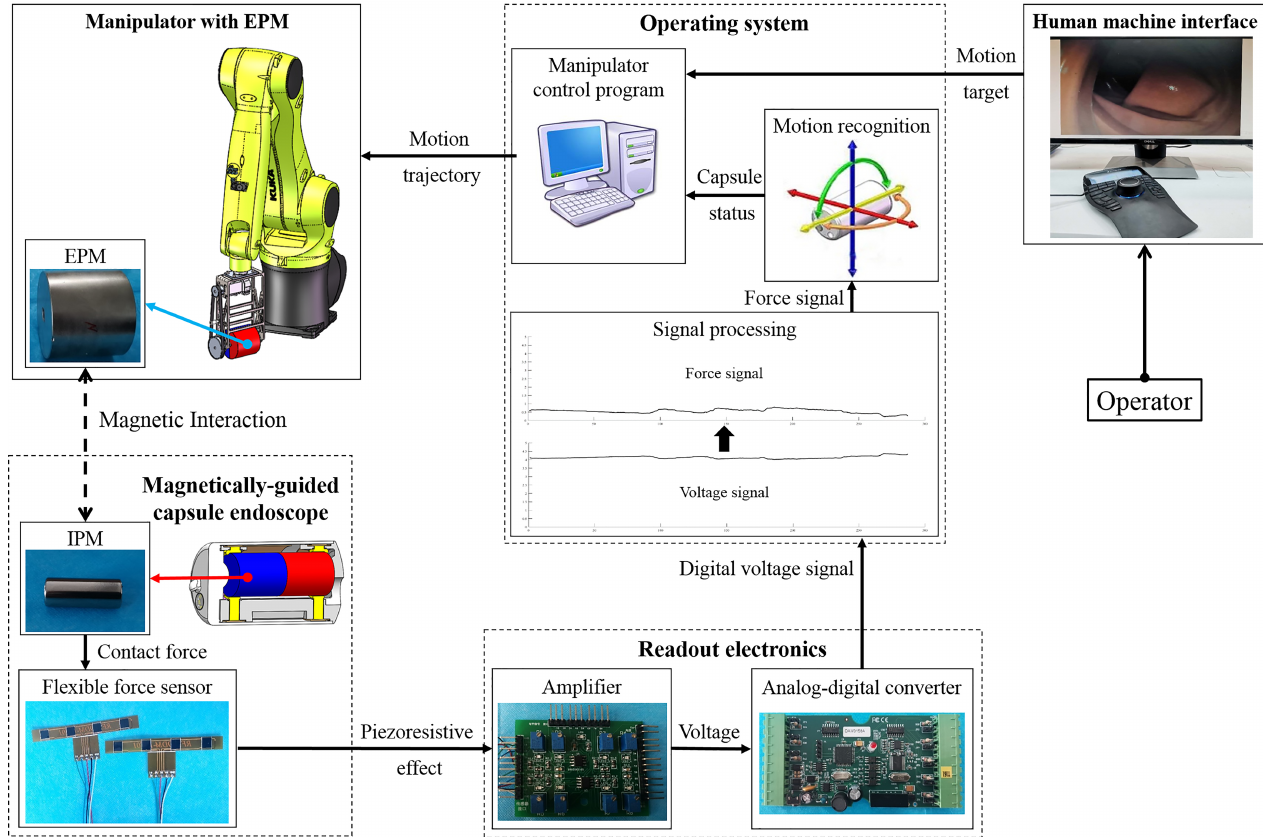
Figure 3. Hardware system of the designed magnetically-guided capsule